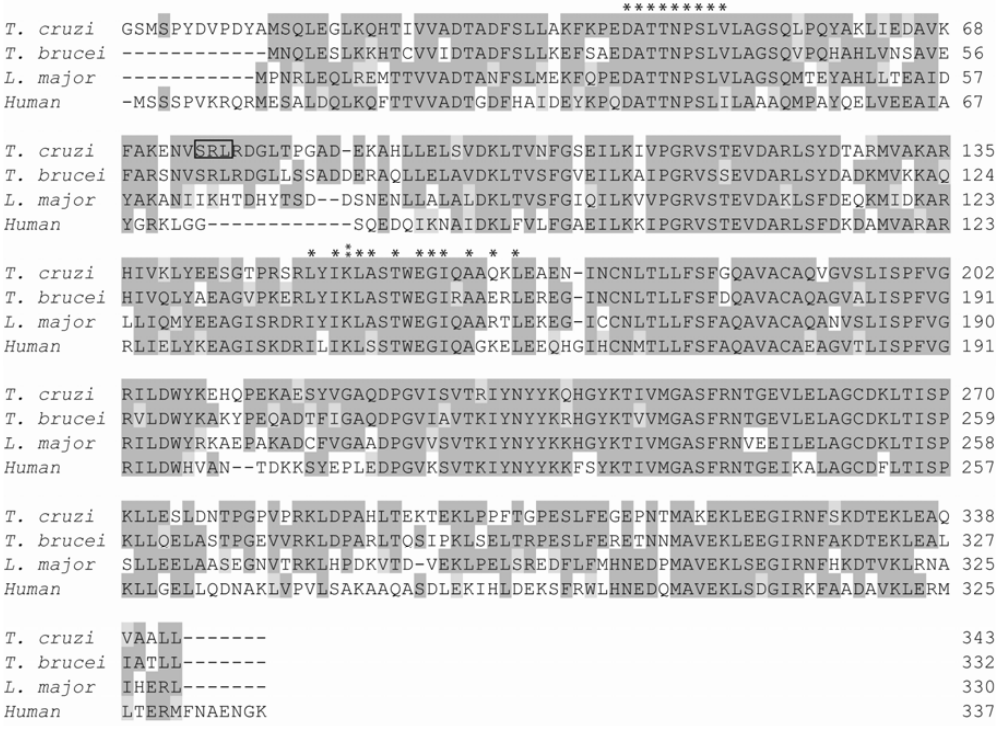
Fig. 8 – Alignment of the deduced amino acid sequences of different transaldolases. The T. cruzi TAL (EU075264) is aligned with those of T. brucei (XP_847390 ), L. major (CAJ03645) and human (NP_006746). A putative PTS 1 (SRL) is boxed. The asterisks indicate the residues conserved in the TAL